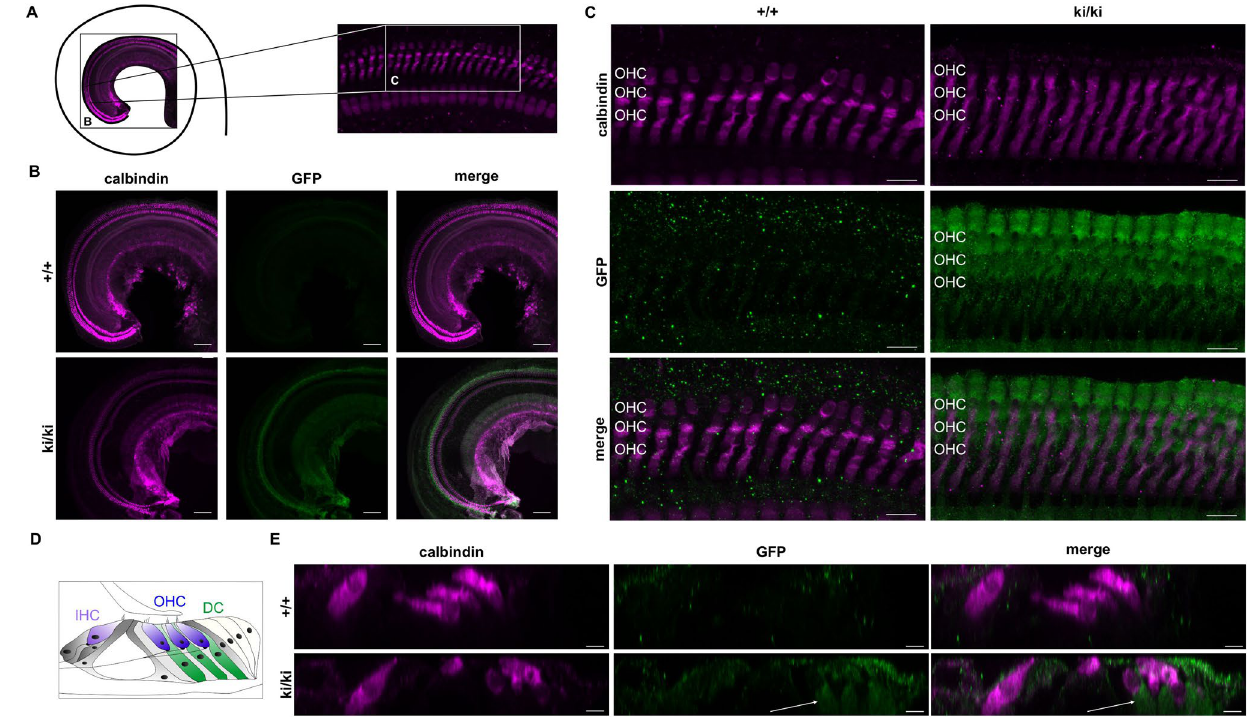
Figure 6. GFP expression in the cochlea of Gnai3 -iresGFP reporter mice at P21. ( A ) Scheme of a top view onto the apical turn of the cochlea and the sites of low and high magnification views shown in ( B , C ). ( B ) Representative low magnification view of a wild-type (top) and a ki/ki (bottom) organ of Corti stained against calbindin (magenta) and GFP (green). GFP expression is restricted to the ki/ki genotype. Calbindin, a marker for IHC and OHC, is detectable in wild-type and ki/ki organs of Corti. Maximum projection of confocal sections is depicted. ( C ) High magnification views of OHCs immunolabeled for calbindin (magenta) and GFP (green) from wild-type and ki/ki animals (P21) as maximum projection of confocal stacks. ( D ) Scheme of an orthogonal cross-section through the organ of Corti. ( E ) Virtual orthogonal section through the organ of Corti, displaying one IHC and three OHCs as well as supporting cells of wild-type and ki/ki mice labelled for GFP (green) and calbindin (magenta). GFP expression was strongest in Deiter’s cells (DC). Arrows indicate DC. Images of wild-type and ki/ki were acquired and displayed with the same settings. Scale bars ( B ) 20 µm, ( C ) 10 µm and ( E ) 5